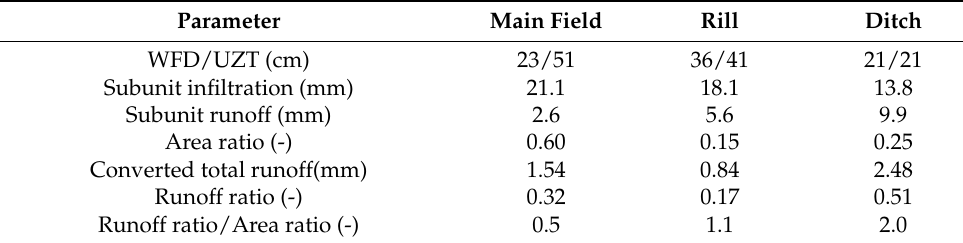
Table 5. Parameters of three kinds of topographic subunits in 20160808 runoff case.